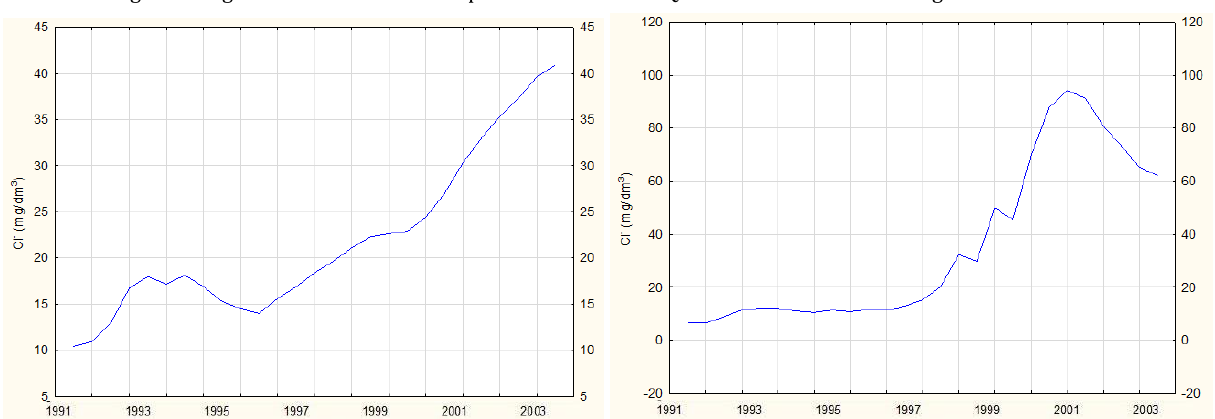
Fig. 4. Changes in chloride content in piezometers T1 and Q1 obtained with the moving median method